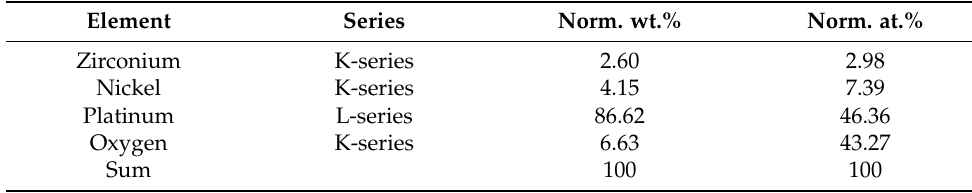
Table 1. Chemical composition of the agglomerate from Figure 4.